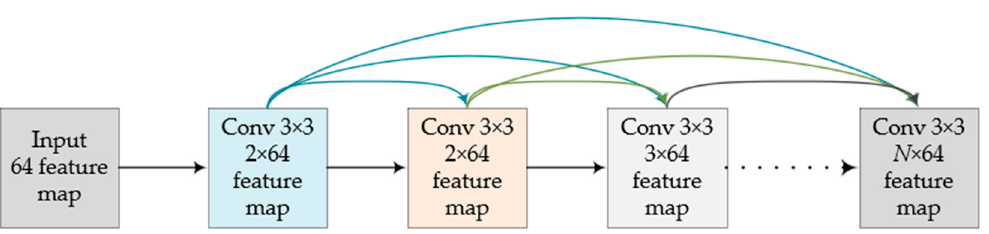
Figure 6. Dense coding structure.